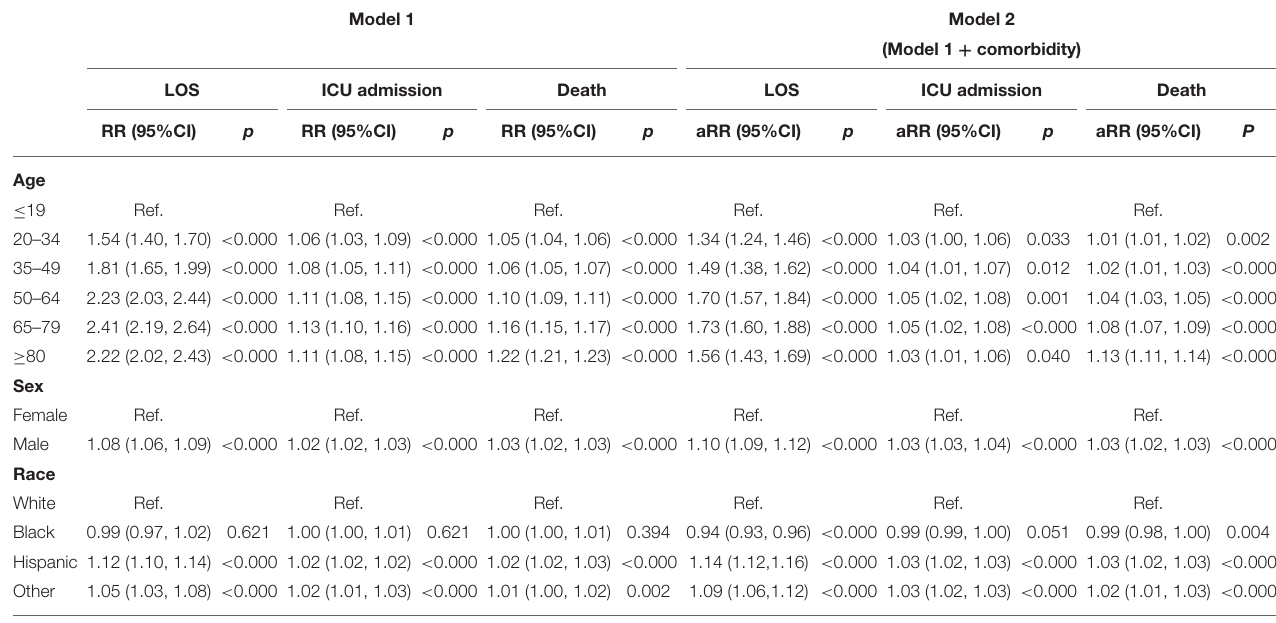
TABLE 4 | Adjusted association between key outcomes and age, sex, and race. Model 1 Model 2